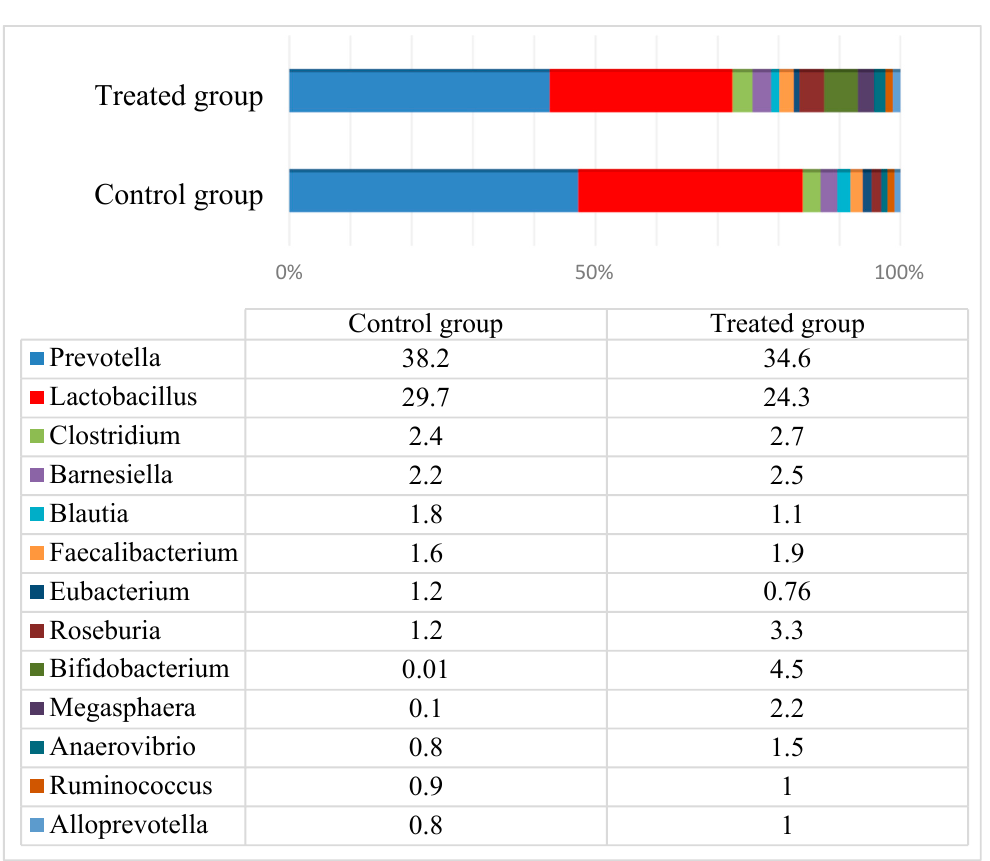
Figure 3. The total microbiota composition in pigs’ feces before the experiment.